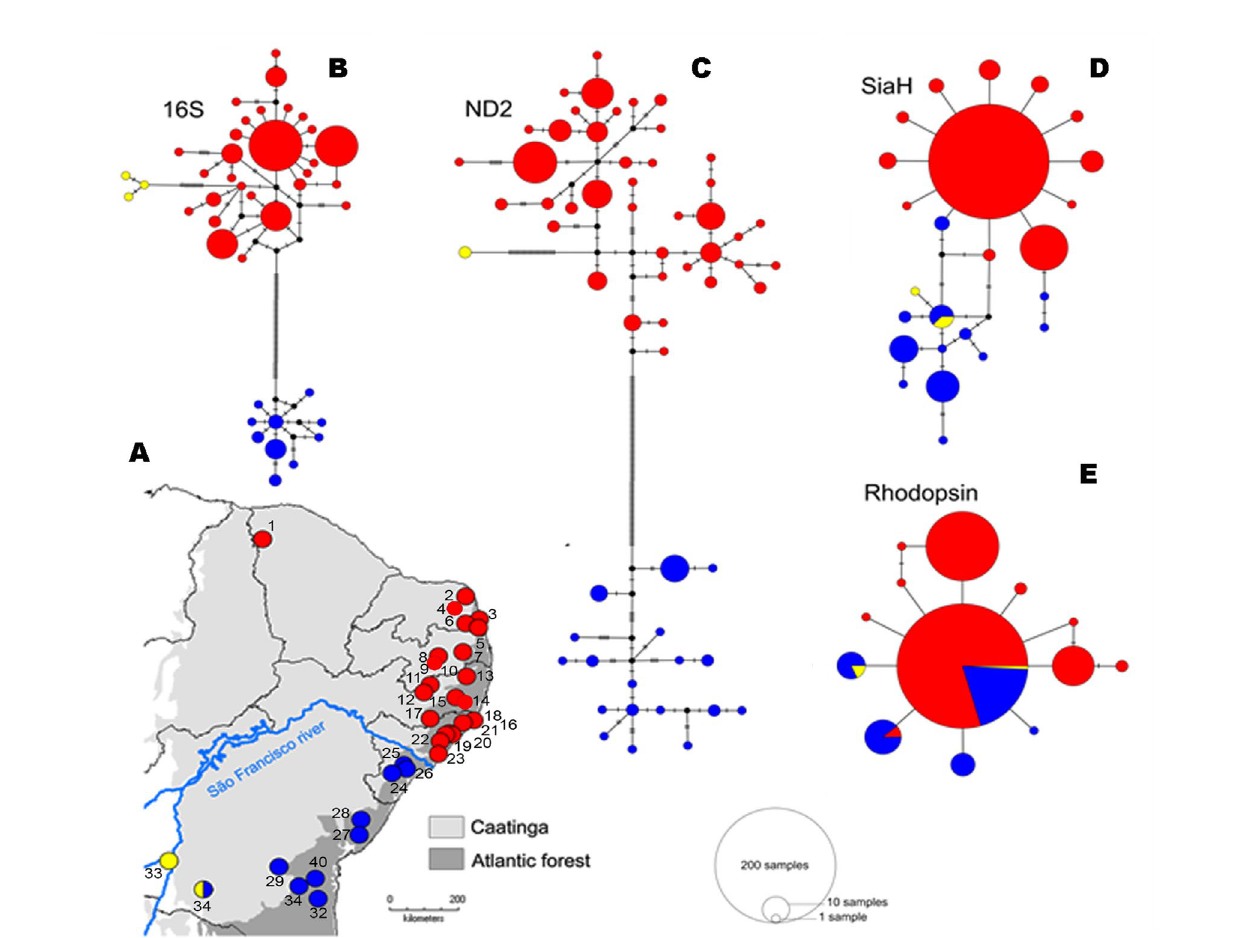
FIGURE 3 | Spatial distribution (A) and haplotypes genealogies for Median-joining analysis of 16S (B) , ND2 (C) , SiaH (D) , and Rhod (E) fragment genes recovered of the P. nordestinus dataset. Each haplotype is represented by a circle whose area is proportional to its frequency (see legends). Samples are colored according to the haploclades recovered in the Bayesian topology and Bayesian analysis of population structure (BAPS) analysis. Red represent the Northern group, blue represent the Southern group, and yellow represent the West group. Note the blue and red lineages of the P. nordestinus bisected by current course of the SFR (light blue dashed). The numbers correspond to the localities named in BAPS analysis ( Supporting information—Figure S1